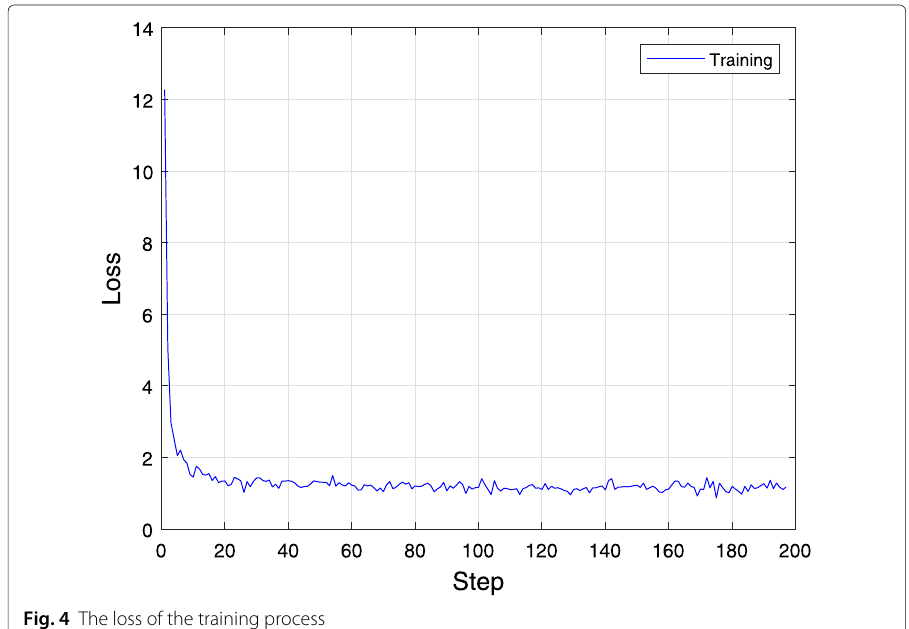
Fig. 4 The loss of the training process